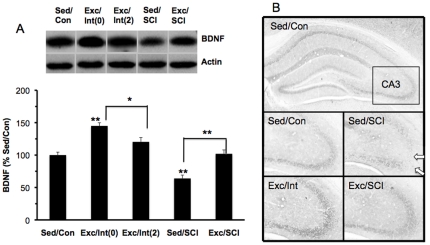
Effects of SCI and exercise on BDNF levels in the hippocampus.(A) Exercise elevated levels of BDNF in intact animals sacrificed on the last exercise day (Exc/Int0) or two days after ceasing exercise (Exc/Int2). SCI reduced BDNF level and exercise prior to SCI prevented this reduction. *p<0.05, **p<0.01. Representative western blot bands for BDNF are shown for each animal group. (B) Microphotographs of representative immunohistochemical sections showing localization of BDNF in the hippocampus. SCI reduced BDNF immunolabeling (white arrows, Sed/SCI) mainly affecting the CA 3 region, but exercise prior to the SCI prevent these effects (black arrows, Exc/SCI).